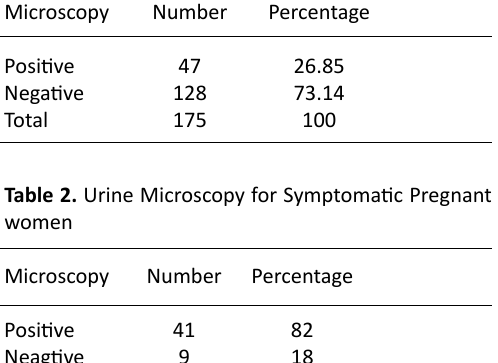
Table 1. Urine Microscopy for Asymptomatic